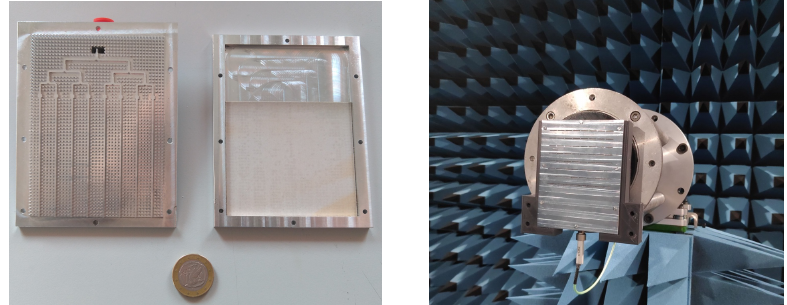
Figure 14. Manufactured prototype: excitation network and substrate arrangement ( left ) and assem- bled antenna in anechoic chamber showing the radiating side ( right ).